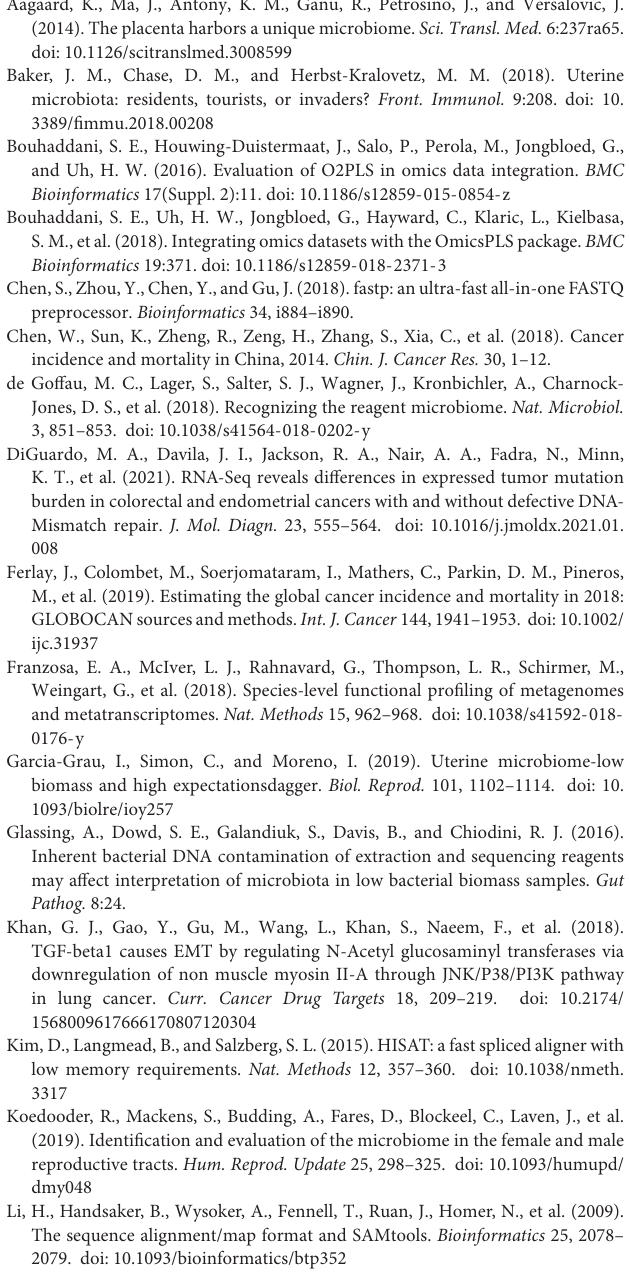
Supplementary Table 1 | Abundance of functionally active microorganisms in all samples. Supplementary Table 2 | Metabolic pathways of functionally active microorganisms. Supplementary Table 3 | Differentially expressed genes between the EC group and the normal group. Supplementary Table 4 | KEGG orthology (KO) enrichment